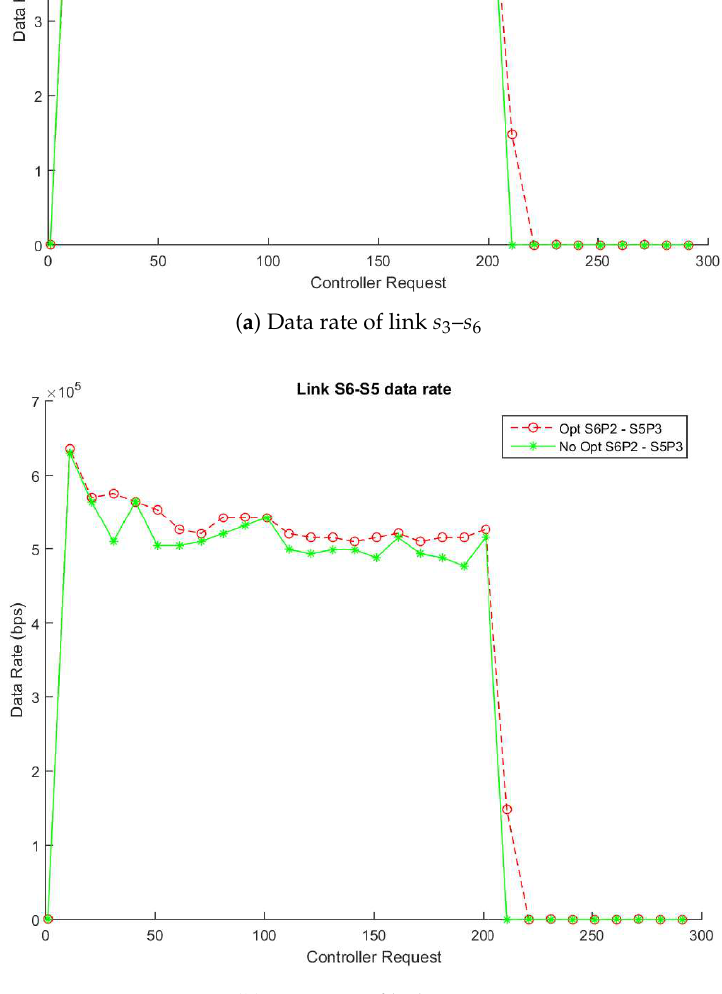
Figure 5. Enhanced vs. Non-Enhanced Data and Error Rate of